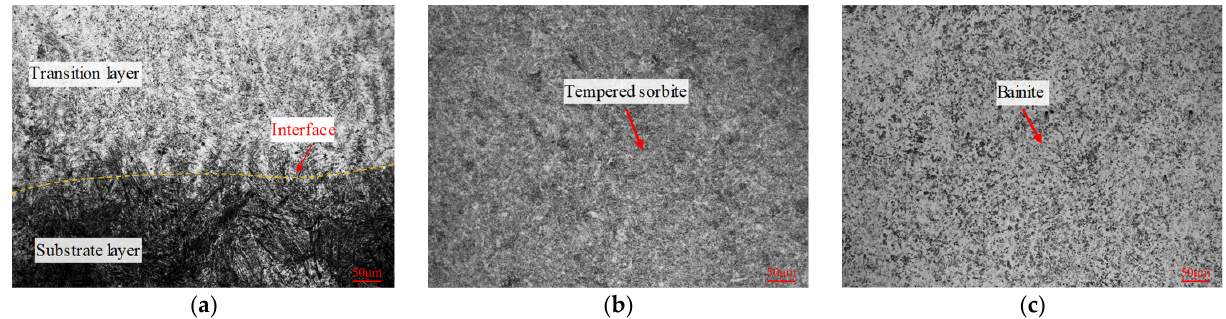
Figure 7. Microstructure of interface A. ( a ) Interface A (position 1). ( b ) Substrate layer (position 2). ( c ) Transition layer (position 3).